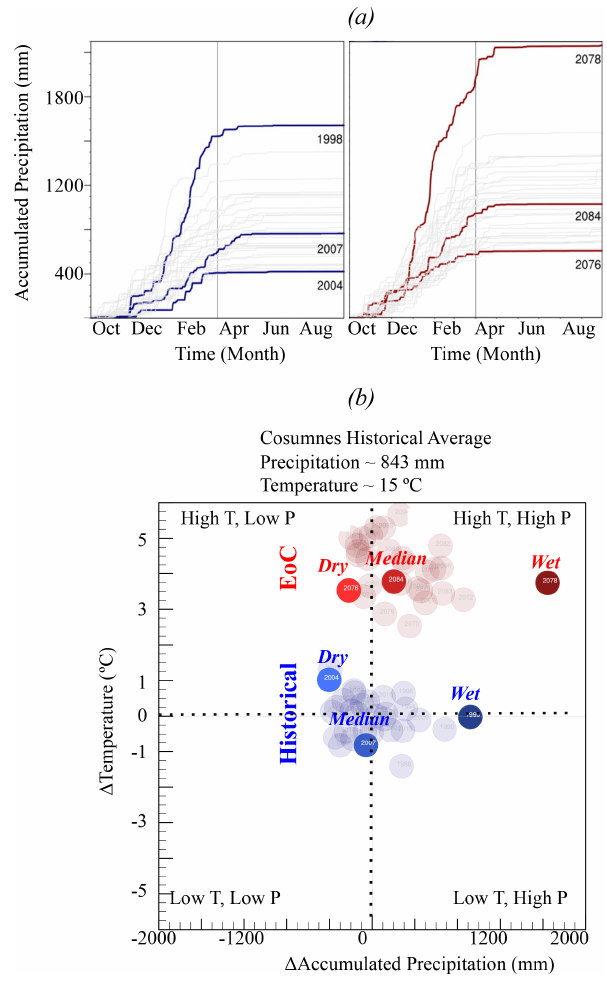
Figure 2. (a) VR-CESM accumulated total precipitation for the his- torical and end-of-century (EoC) simulations and (b) quadrants for differences between each individual water year (WY) and the histor- ical average temperature and accumulated precipitation in the Co- sumnes watershed. The historical and EoC dry, median, and wet WYs are indicated in blue and red,